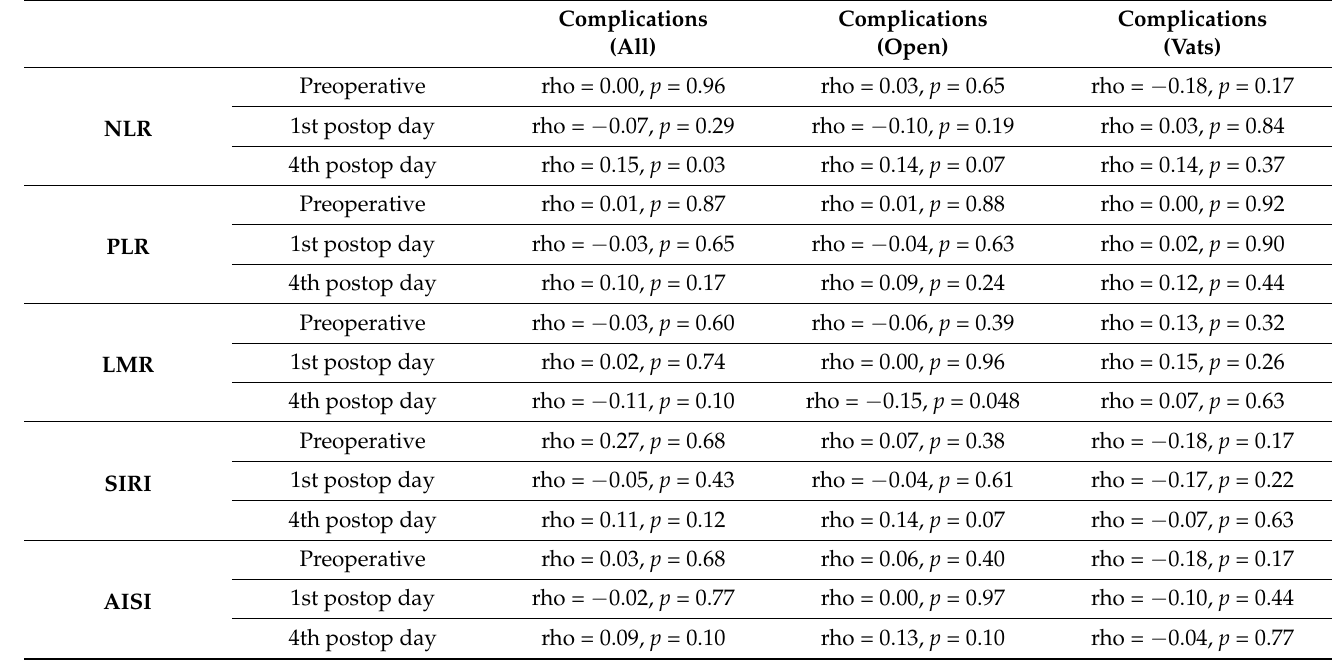
Table 2. Blood cell count indexes and postoperative complications in the global cohort and the open and VATS surgery